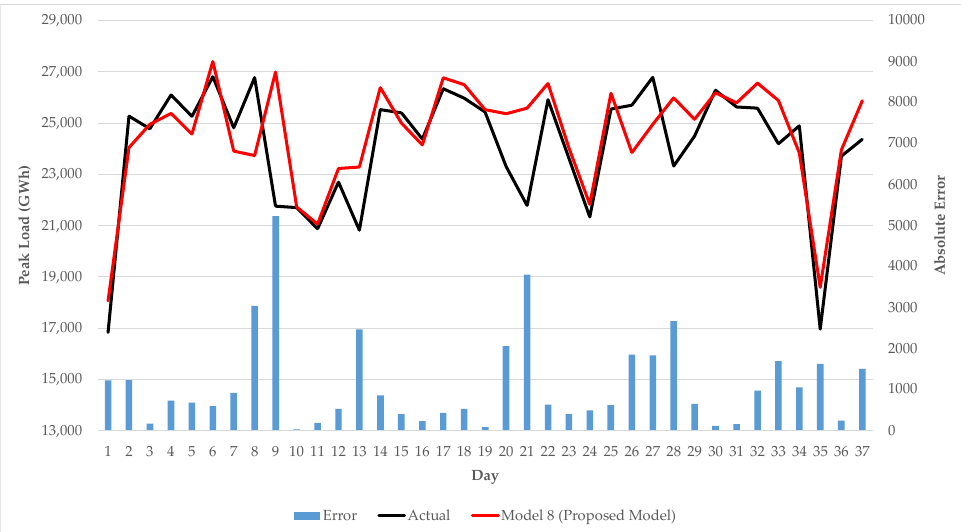
Figure 12. Forecasting error of the proposed model on testing dataset.